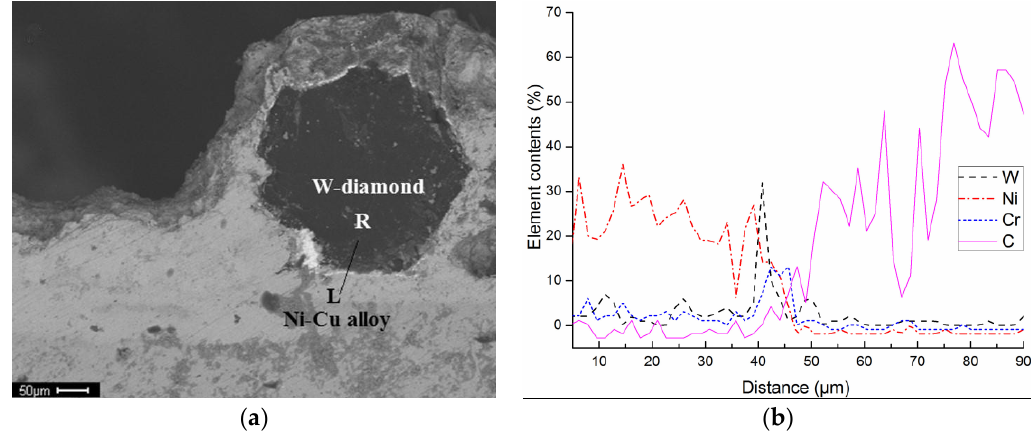
Figure 7. Backscattered SEM image ( a ) and corresponding EDS ( b ) between Ni-Cu alloy and W-coated diamond [35], Taylor & Francis, 2018.